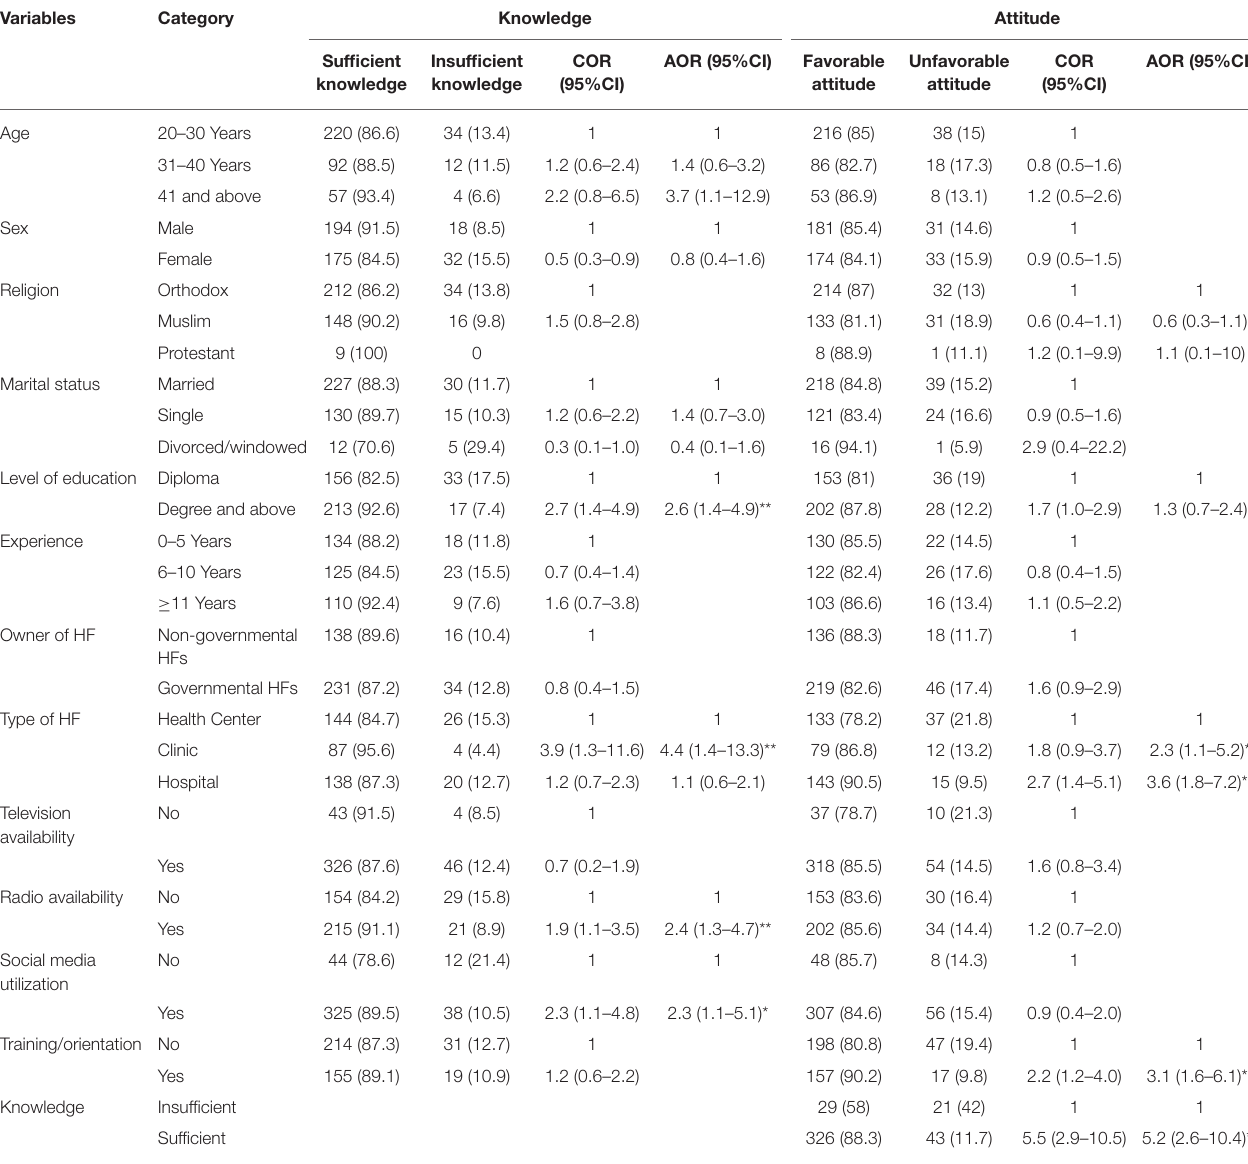
TABLE 5 | Factors associated with sufficient knowledge and favorable attitude regarding COVID-19 in Dessie city, northeast Ethiopia ( N = 419).